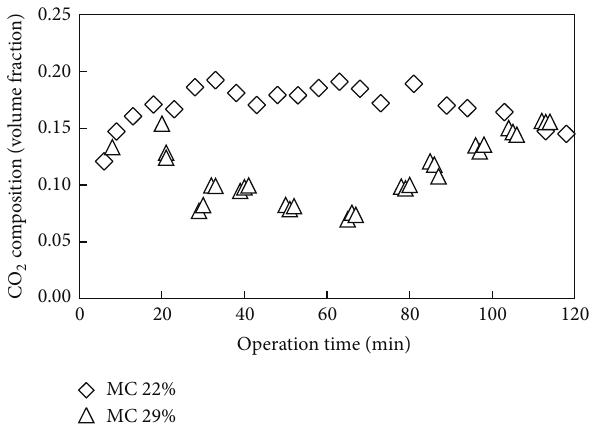
Figure 4: Carbon dioxide content in syngas over operation time for fuel of different initial moisture content.